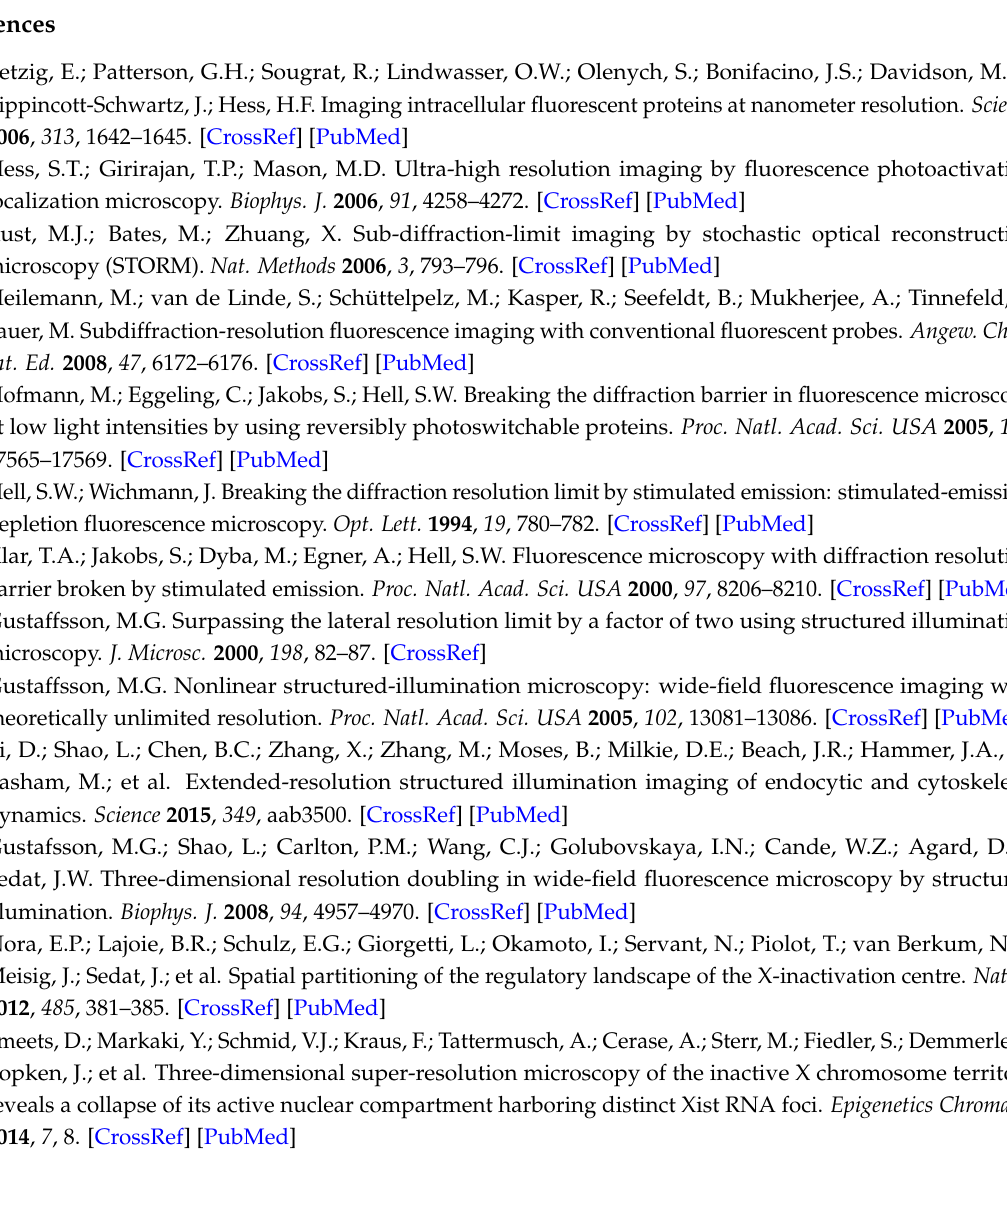
Figure S1: (a) Analysis procedure for intensity-weighted FLIM. The intensity image (grey-scale), acquired with the FLIM detection camera, is multiplied by the lifetime map (colour-scale, RGB) to obtain the intensity-weighted FLIM image; (b) Schematic of DDR1 receptor dimers with SNAPtags. The SNAP protein was incorporated into the extracellular region. It was inserted into the flexible juxtamembrane region that follows the two globular domains, the first of which contains the collagen binding stie. Intracellular is the kinase domain which is activated following DDR1 binding to collagen. Figure S2: (a) fluorescence lifetime map and (b) intensity weighted